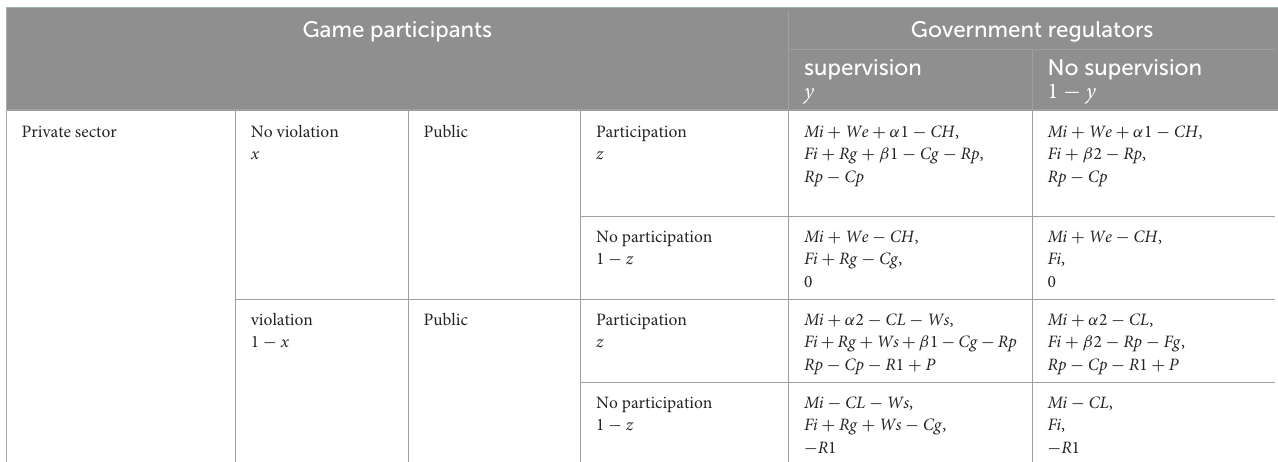
TABLE 2 Government, private sector, and public payment-revenue matrix 3